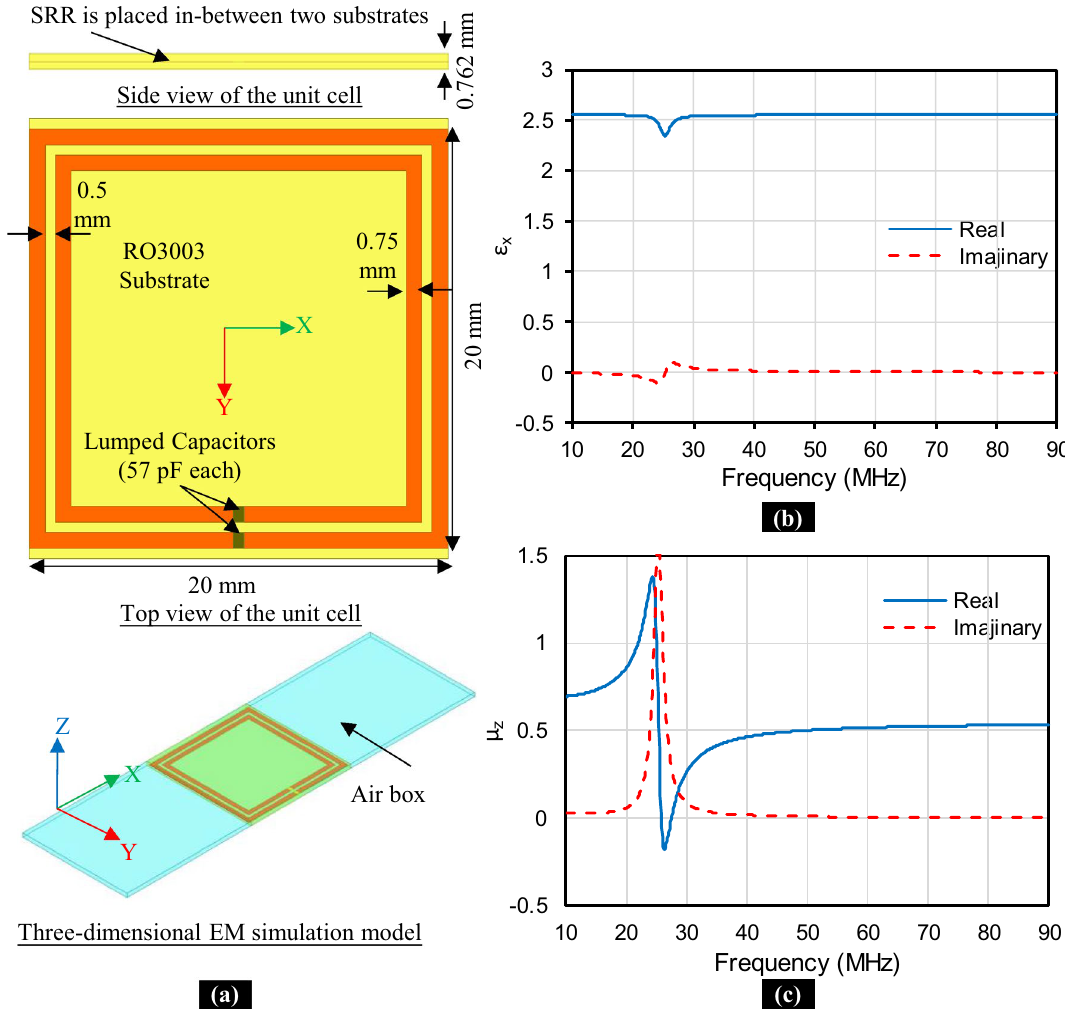
Figure 2. Proposed metamaterial inspired geometry. (a) Unit cell of SRR and EM simulation model. (b) Effective relative permittivity (ε x ). (c) Effective relative permeability (μ z